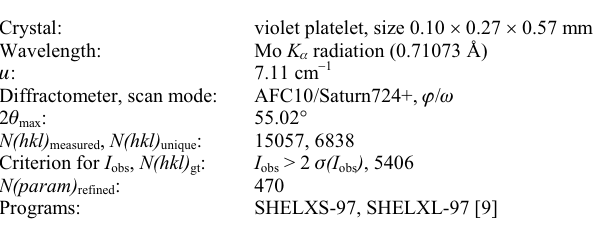
Table 1. Data collection and handling.